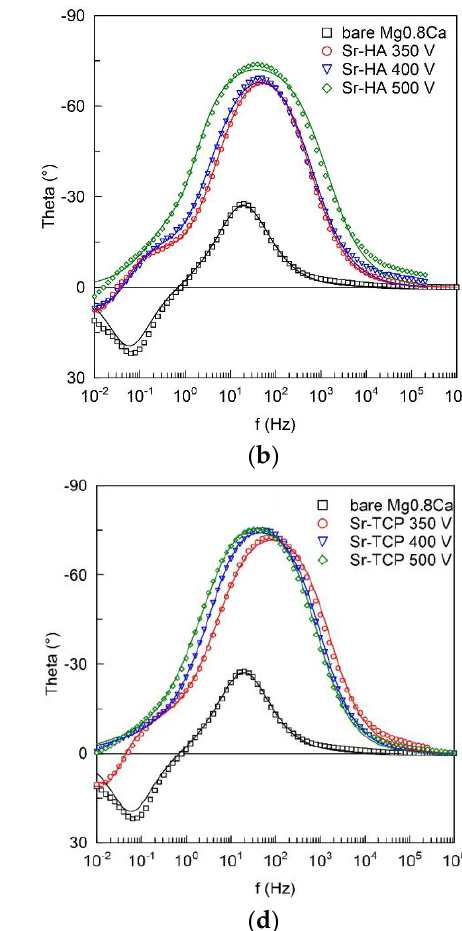
Figure 12. Bode plots, obtained in 0.9% NaCl for the bare Mg0.8Ca, Sr-HA ( a , b ) and Sr-TCP ( c , d ) coated samples.